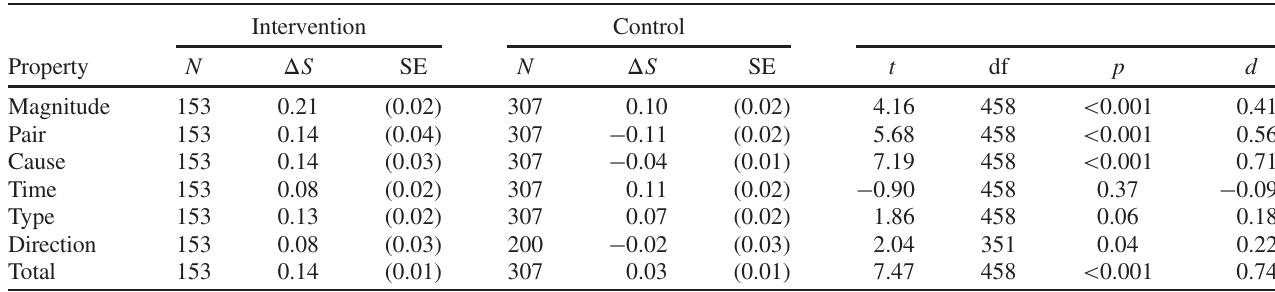
TABLE VI. Comparison of changes in scores ( Δ S ) between pre- and post-tests for each group. Differences between the groups were significant for the overall score changes and the magnitude, interaction pair, and cause at the p < 0 . 001 level. Moderate to large effect sizes were measured for the magnitude, pair, and cause properties while a small effect size was noted for the direction property. N ’ s are the counts of students answering questions with these properties on the post-test and SE is the pooled standard error between the pre- and post-tests for each